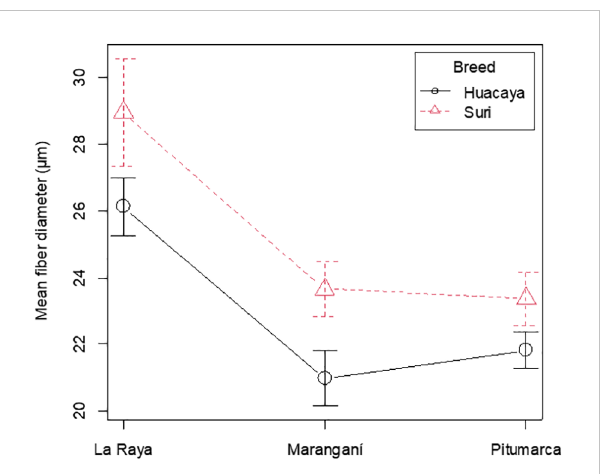
FIGURE 3 Distribution of mean fi ber diameter in Huacaya and Suri colored alpacas ( x -axis). The y -axis label refers to frequency.